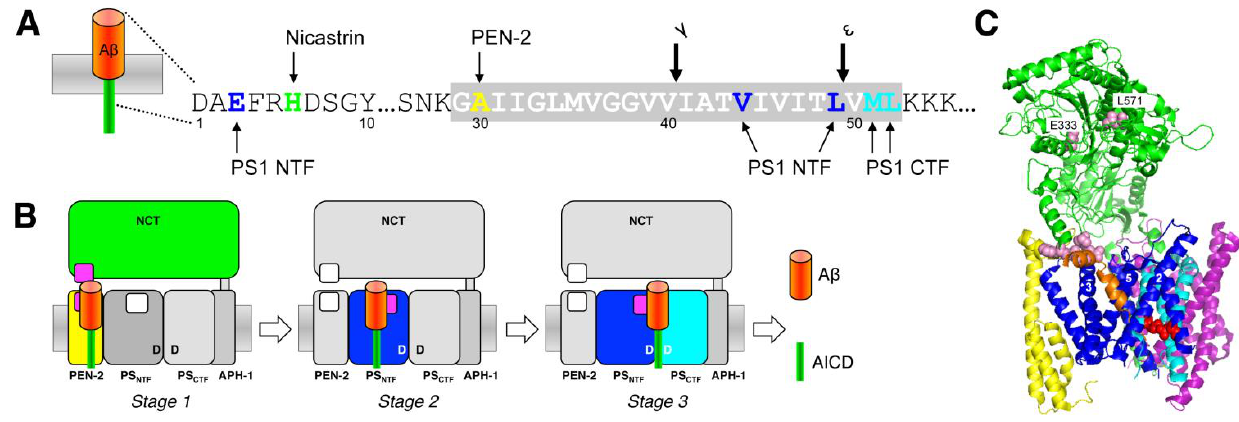
FIGURE 3: Substrate recruitment of C99 by γ -secretase. (A) Schematic representation of the most prominent C99 residues interacting with γ - secretase subunits as determined by site-directed photocrosslinking using the unnatural amino acid p -benzoyl-phenylalanine. (B) Model de- picting the stepwise translocation of C99 from exosites (purple) in NCT and PEN-2 (stage 1) and the PS1 NTF (stage 2) to the active site (stage 3). (C) Structure of γ -secretase (5FN3) with a co- isolated α -helix (orange), which might represent a substrate-mimic. Red spheres depict the active site aspartate residues. Light pink spheres represent candidate sites for substrate interactions with NCT. Although not visible in this view, L571 is less buried than E333. Numbers indicate TMDs of the PS1 NTF that surround the substrate- mimicking α